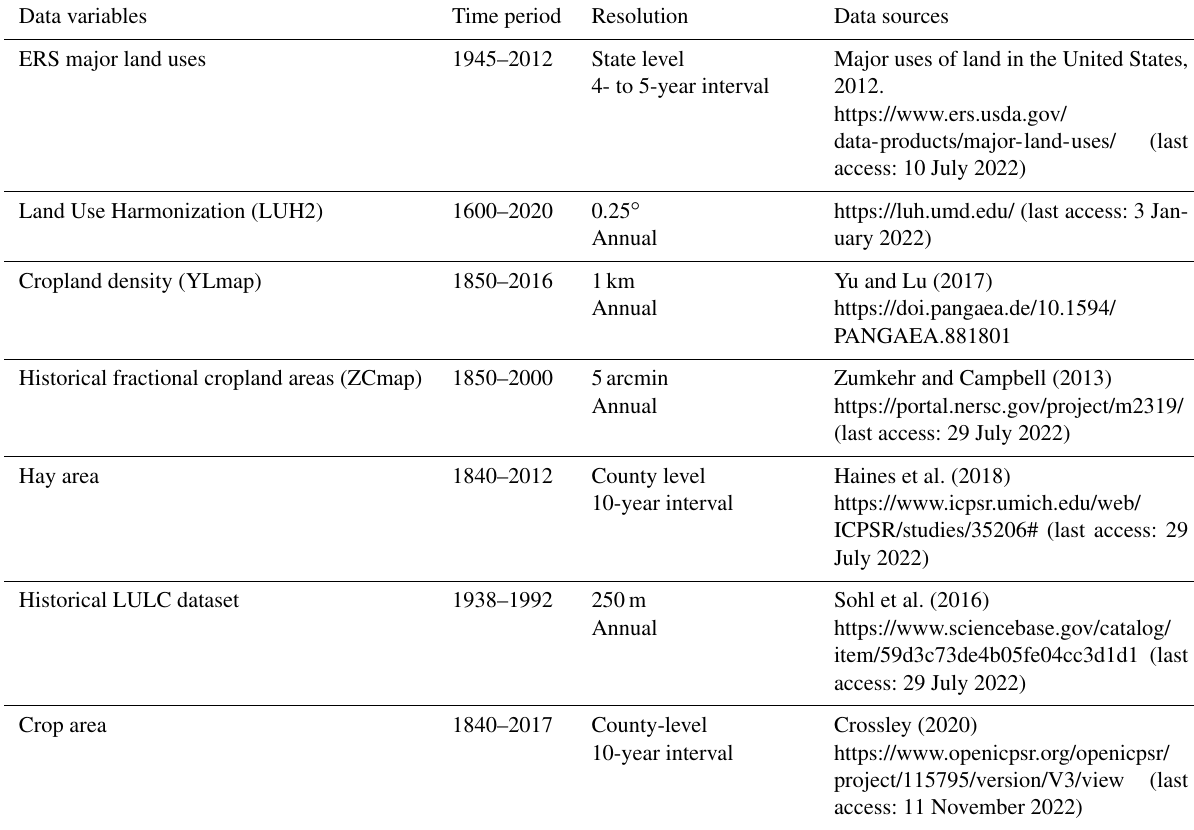
Table A2. Land use and land cover datasets used for comparison. Data